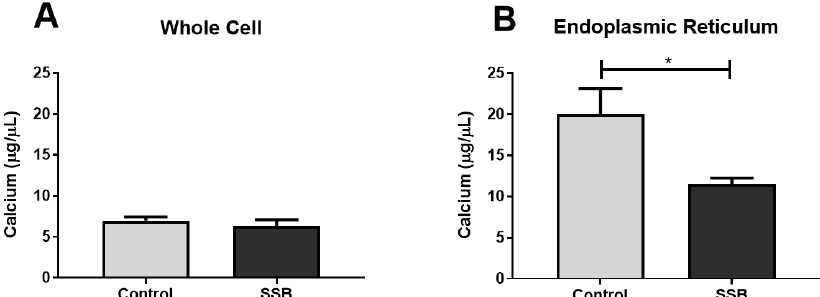
Figure 3. Hepatic calcium levels in response to SSB intake. ( A ) whole cell homogenate, and ( B ) isolated ER fraction. Data are displayed as mean ± SEM. * p < 0.05 ( n = 8).